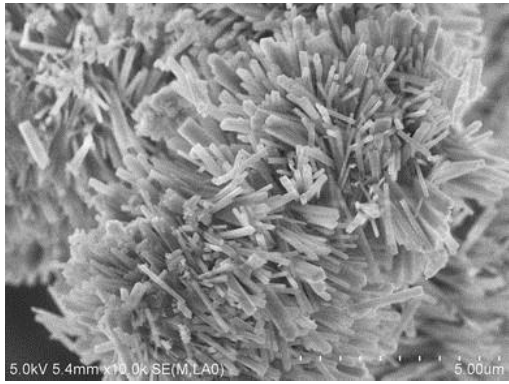
Figure 7. A wool-ball-like zeolite composed of nano-sized MFI crystals [62]. Copyright Springer, 2016.